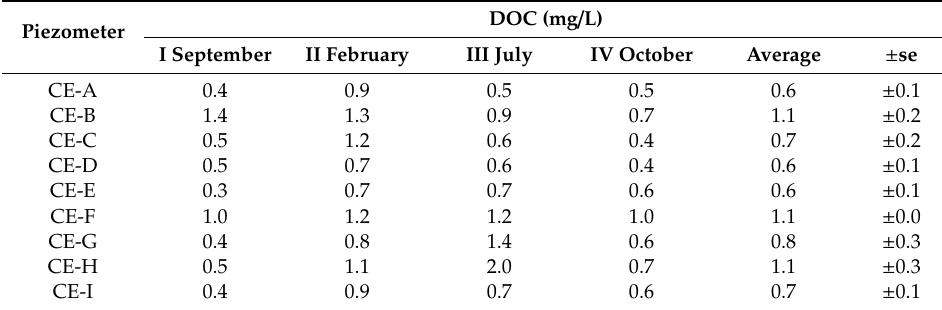
Table 6. Dissolved Organic Carbon (DOC) values determined in each piezometer (CE-A, CE-B, CE-C,